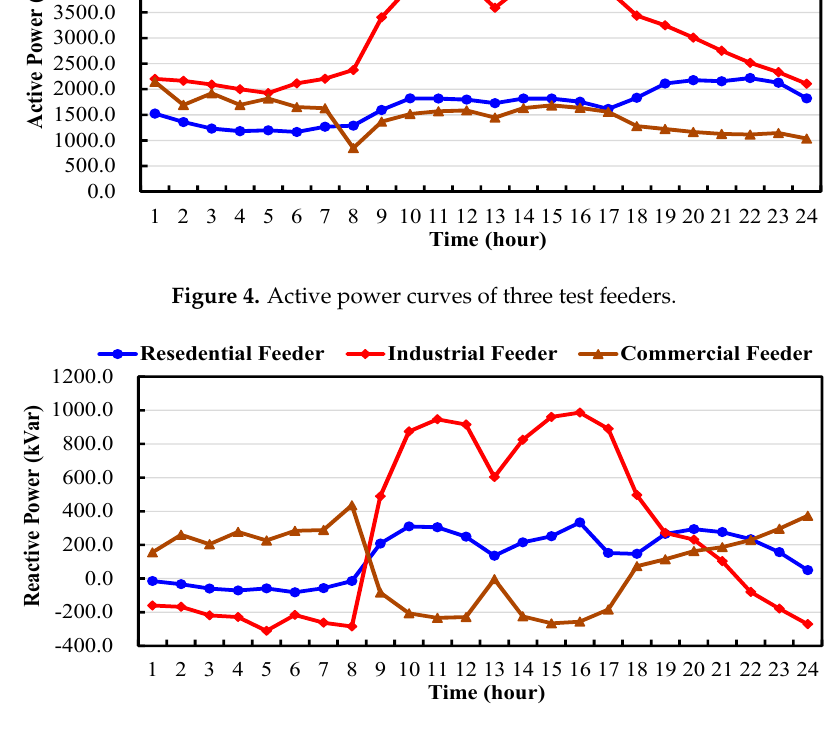
Figure 5. Reactive power curves of three test feeders.